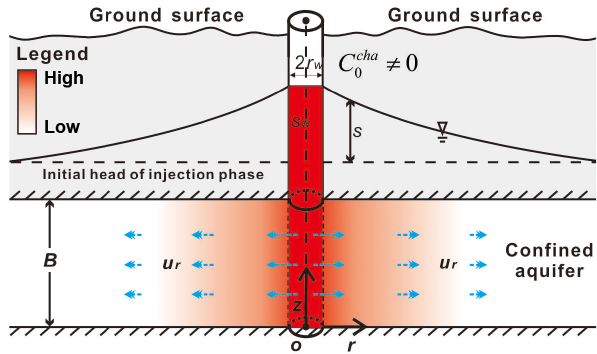
Figure 1. The schematic diagram of the SWPP test at the beginning of the rest phase when the chase concentration is not